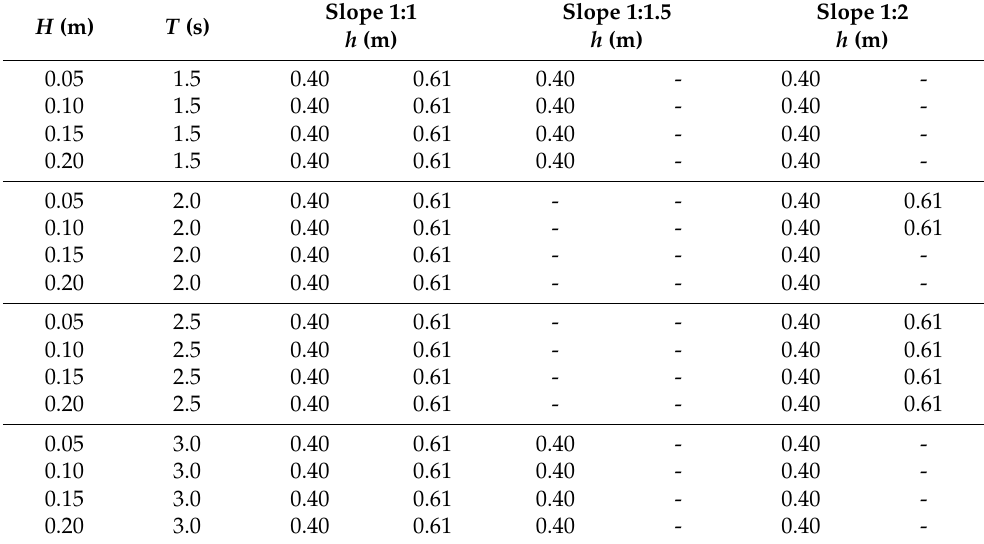
Table 2. Regular wave characteristics for adherent revetment